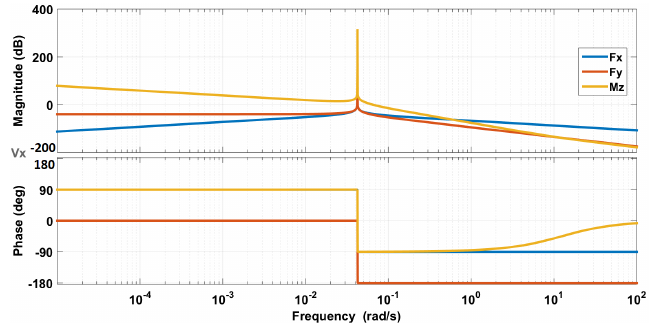
Figure 13. Bode diagrams for the longitudinal velocity